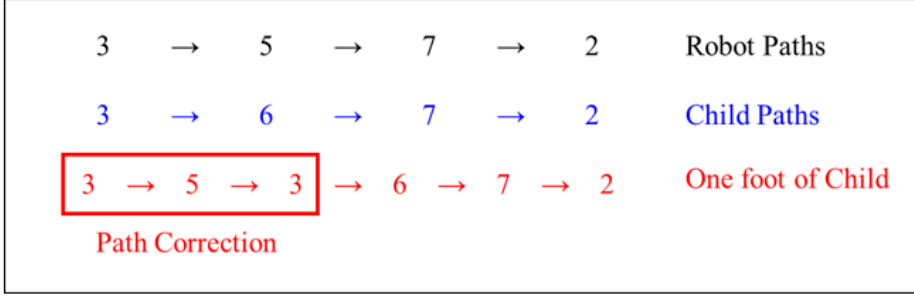
Figure 9. Indicator B4_4 (correct path before incorrect path).